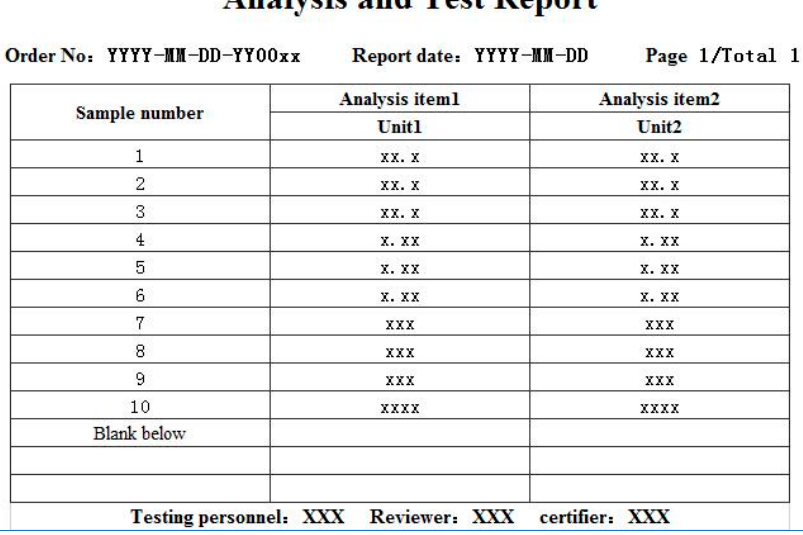
Figure 6. Automatic data report generation module. 3.4. Data Manage and Distribute After analysing, processing, and compiling the experimental data to generate the standard report, the analysts have no unified management means and maintenance mech- anism for their storage, maintenance, submission and distribution [26]. People save data report documents locally according to their personal habits, often without follow-up maintenance and disaster recovery measures, yet there can be data unavailability caused